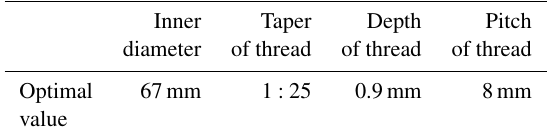
Table 4. Optimized parameters of the pressure probe and its thread. Inner Taper Depth Pitch diameter of thread of thread of thread Optimal 67mm 1 : 25 0.9mm 8mm